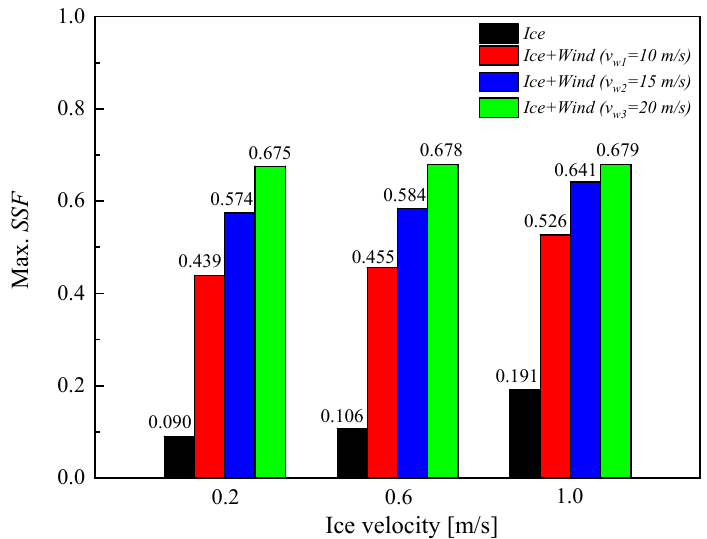
Figure 20. The maximum SSF of the vehicle under combined ice and wind loads. Table 1. The maximum SSF of the vehicle and difference under various conditions.